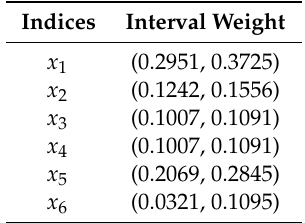
Table 10. The interval weight of the index.